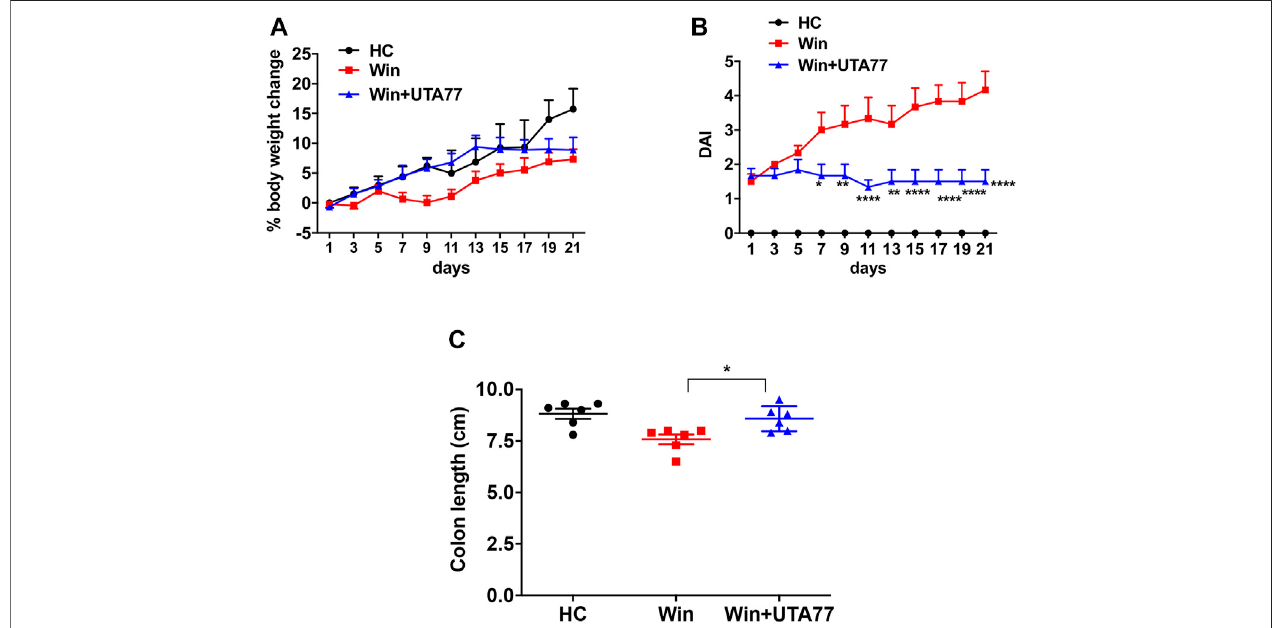
FIGURE7| EffectofUTA77onthepathologyofspontaneouschroniccolitisinWinniemice. (A) %bodyweightchangeand (B) DAIofhealthycontrols(HC),Winnie controls(Win),and UTA77-treatedWinnie group(Win +UTA77). Statistical signi fi canceamonggroups evaluatedbytwo-way ANOVAfollowedbyTukey ’ sposttest. *p < 0.05, **p < 0.01, ***p < 0.001, and ****p < 0.0001 vs. Winnie . (C) Colon length evaluated by one-way ANOVA followed by Tukey ’ s posttest. Data expressed as mean ± SEM ( n (cid:1)